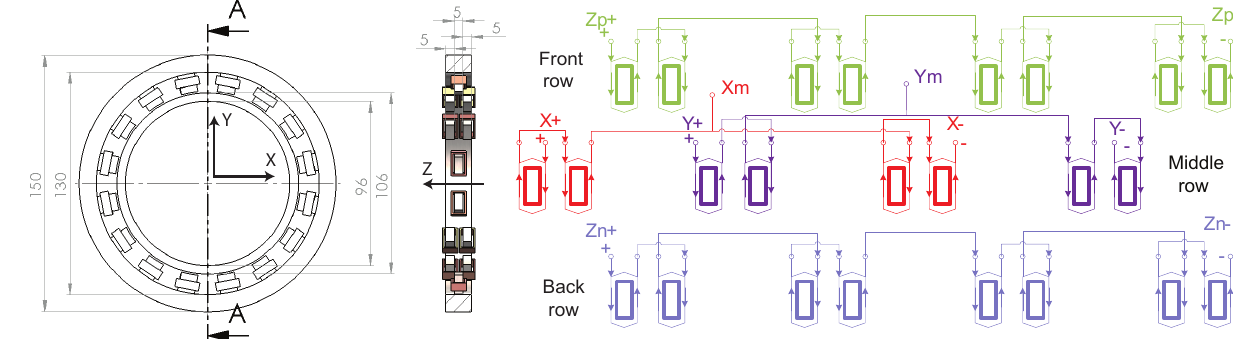
Figure 3. Mechanical dimensions of the displacement sensor and the winding scheme for all three measurement axes. The axial measurement is achieved using the same stator stack geometry as for radial direction measurement, but all the four pole pairs of the stack are connected in series, as illustrated in the connection diagram in the Figure 3. All the four pole pairs of the stator stack are used to reject the sensitivity of the axial sensing circuit to the radial displacement change. The differential measurement for the axial direction is achieved by utilizing two sensor identical stacks in axial direction, defined as front and backrow in Figure 3. The rotor piece width in the example sensor design is 10 mm, from which results that in the centered position the rotor piece will overlap with the axial tooth only by half of the tooth width. This overlapping on both halves of the axial sensor stack as illustrated in Figure 5 allows the self-inductance of the front and back row sensing pole pairs change differentially when the rotor position changes in the axial direction.